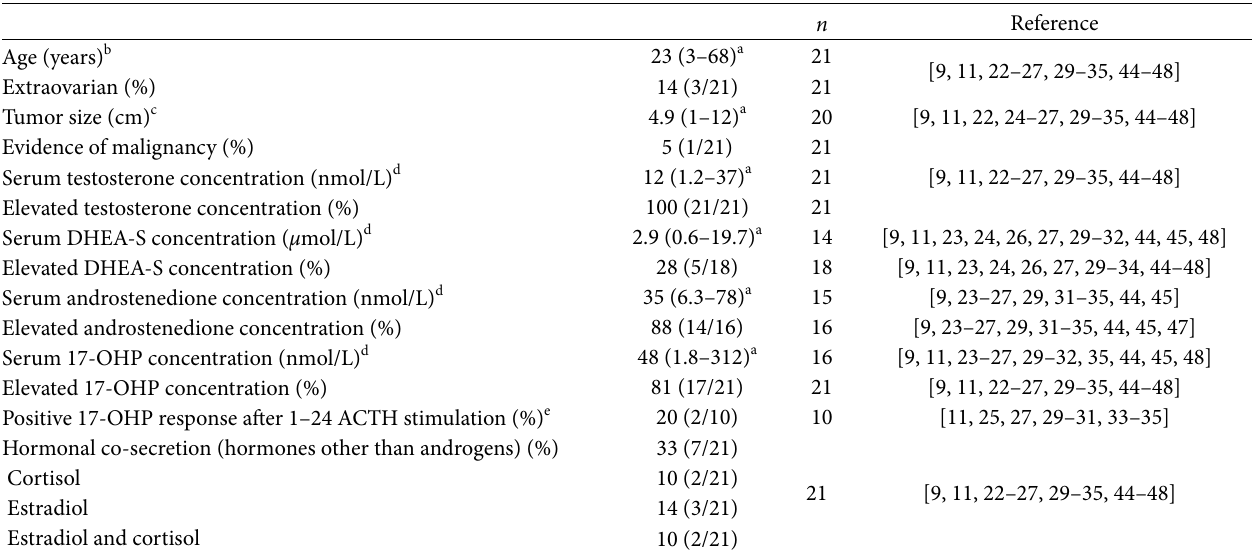
Table 3: A summary of steroid cell tumors, not otherwise specified (SCT–NOS) with 17-OHP concentration reported ( 𝑛 = 21 , including the current case). Please refer to Supplementary Table S1 for a detailed summary of all